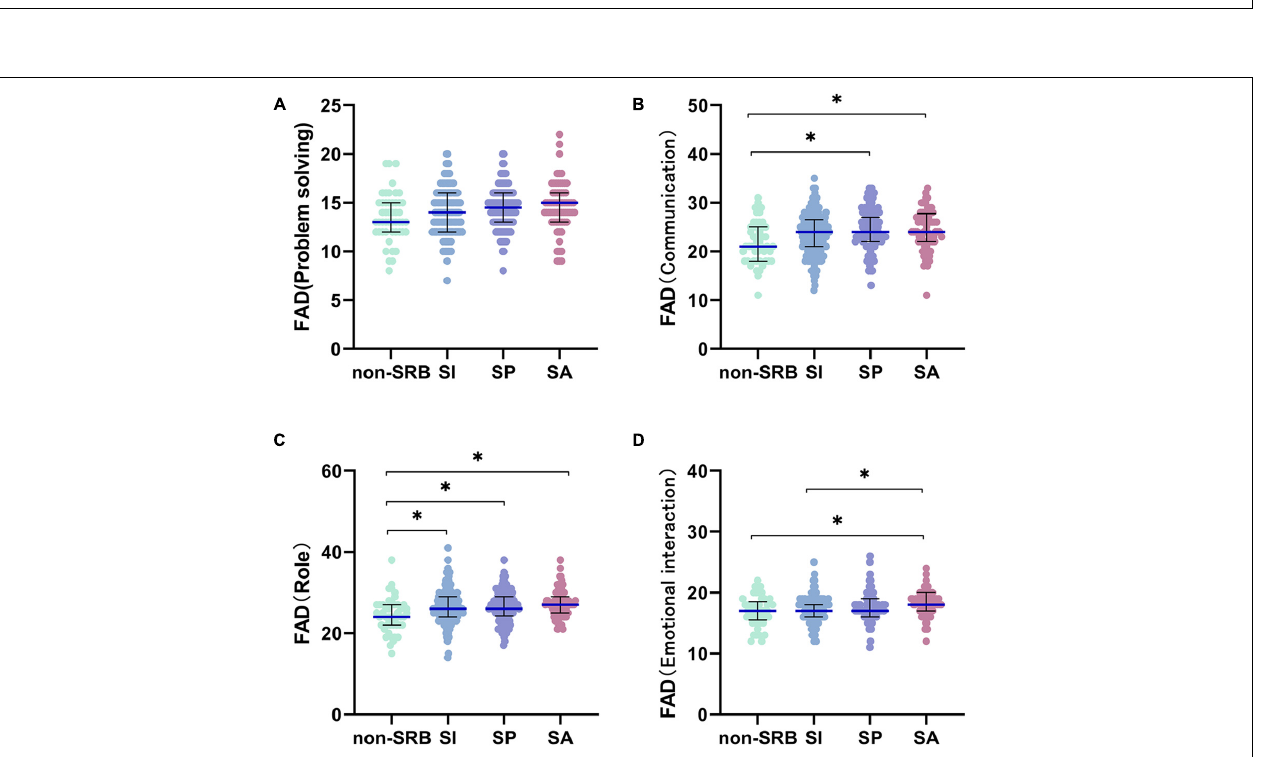
FIGURE 4 | Pairwise comparison of EMBU. (A) Factor I of father. (B) Factor IV of father. (C) Factor I of mother. (D) Factor IV of mother. (E) Factor V of mother. ∗ P < 0.05. Non-SRB, group without suicide-related behavior; SI, group with suicidal ideation; SP, group with suicidal plan; SA, group with suicidal attempt.